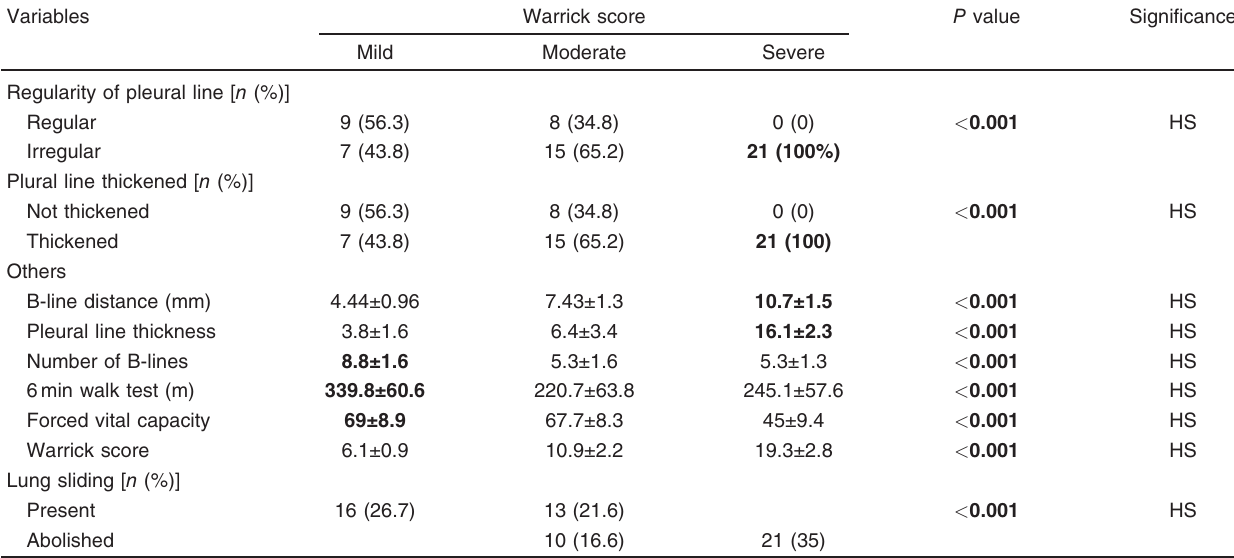
Table 7 Comparison of pleural line and other findings in different severity degrees among cases Variables